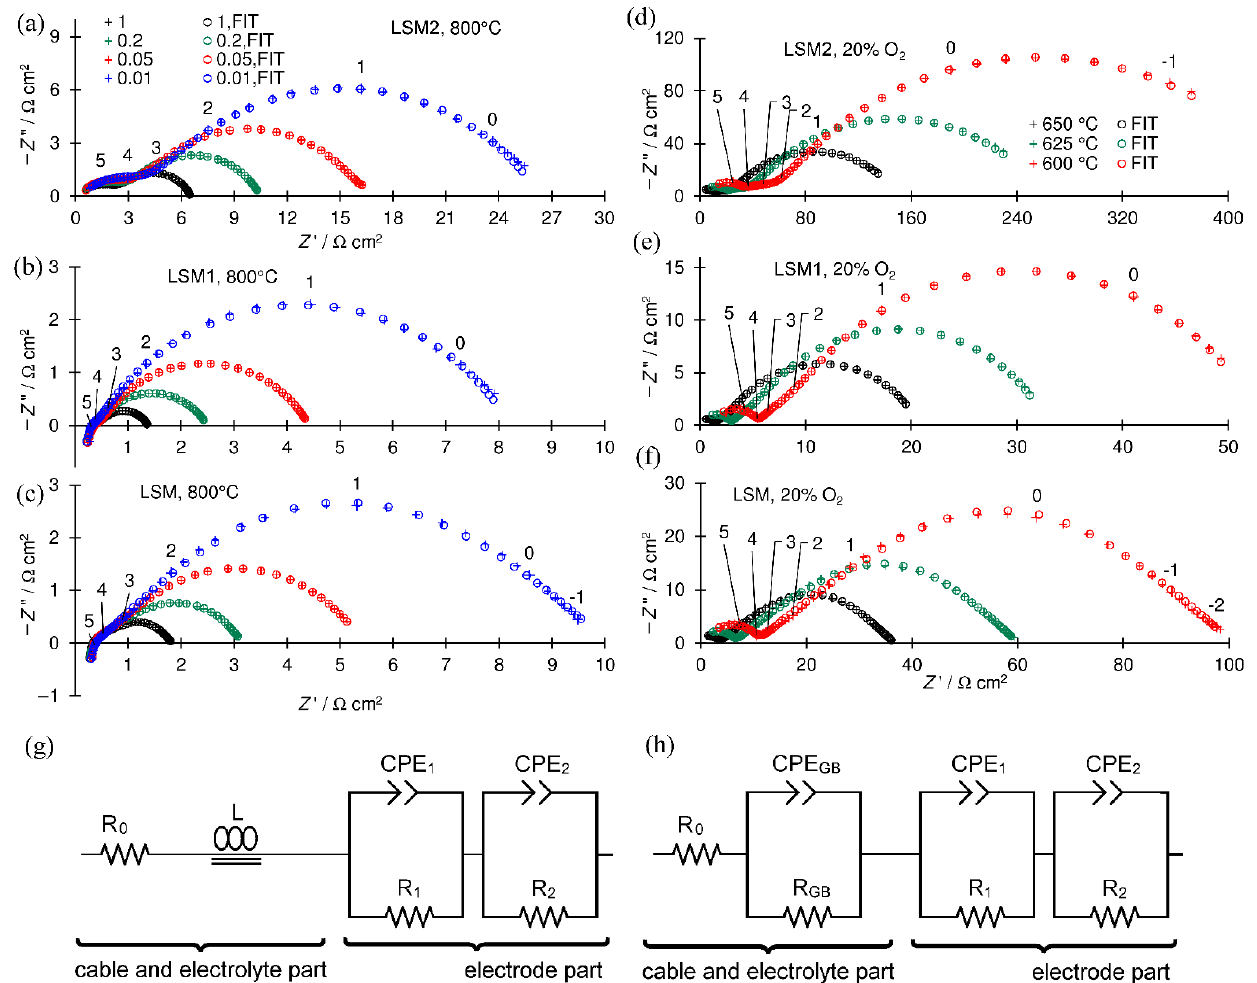
Figure 5. Example of recorded EIS spectra: ( a – c ) t 800 °C and P (O 2 ) P –1 = 1, 0.2, 0.05, and 0.01 for black, green, red, and blue, respectively; ( d – f ) at P (O 2 ) P –1 = 0.2, and at 650, 625, and 600 °C— for black, green, and red, respectively; ( a , d ) LSM2 cathode; ( b , e ) LSM1 cathode; ( c , f ) LSM cathode; crosses experimental points, circles fitted points, numbers above enlarged crosses denote the logarithm of the frequency, and ( g , h ) electrical equivalent circuits used for fitting spectra; all spectra are shifted along the x-axis near the origin to facilitate comparisons.